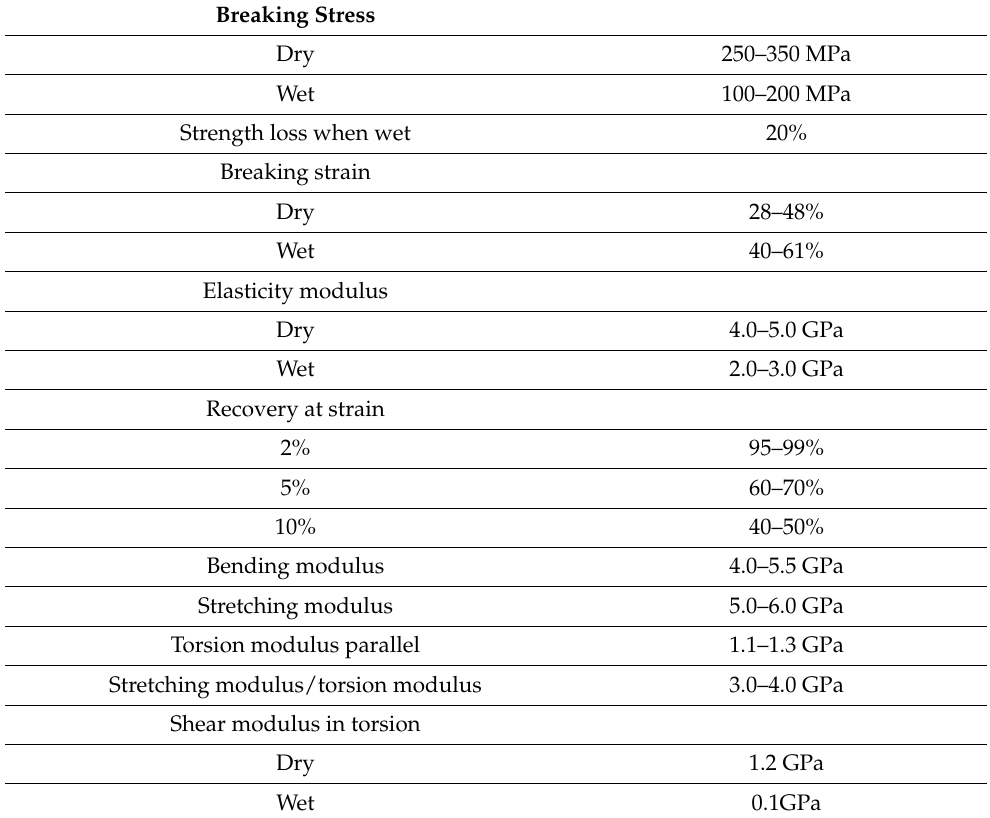
Table 7. Mechanical properties of wool fiber at 22 ◦ C [89].